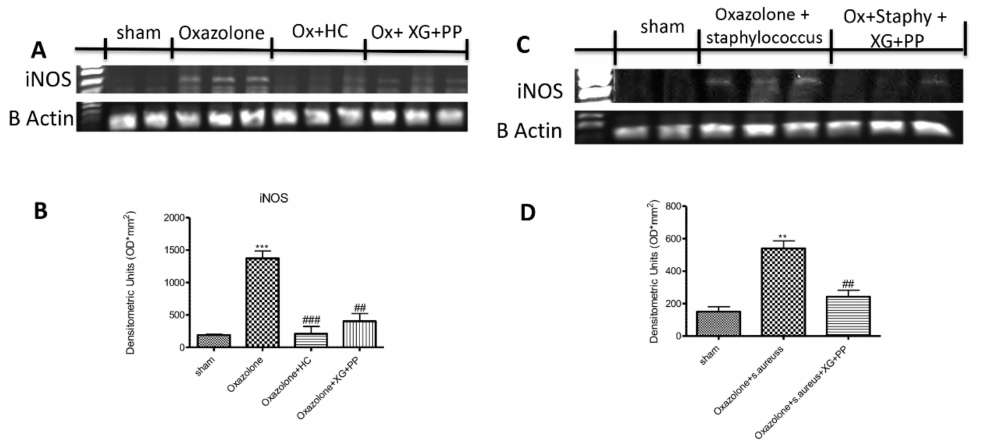
Figure 5. E ff ects of xyloglucan and pea protein on inducible nitric oxide synthase (iNOS) against oxazolone and oxazolone + s. aureus superinfection: The expression of iNOS mRNA was increased in mice of vehicle groups that received oxazolone treatment and oxazolone + S. aureus compared to the sham-operated mice. Moreover, XG + PP treatment and hydrocortisone administration significantly decrease iNOS mRNA levels ( A , B ). Furthermore, the administration of XG + PP significantly reduces the iNOS mRNA level in animals that underwent oxazolone + S. aureus superinfection ( C , D ). *** p < 0.001 vs. sham; ** p < 0.01 vs. sham; ### p < 0.001 vs. oxazolone; ## p < 0.01 vs. oxazolone; ## p < 0.01 vs. oxazolone +